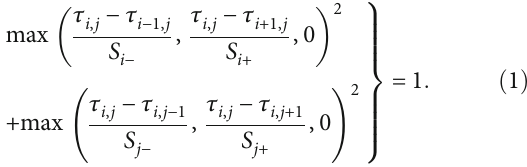
Figure 9: Geometries of the control volumes of the four fractured wells of model